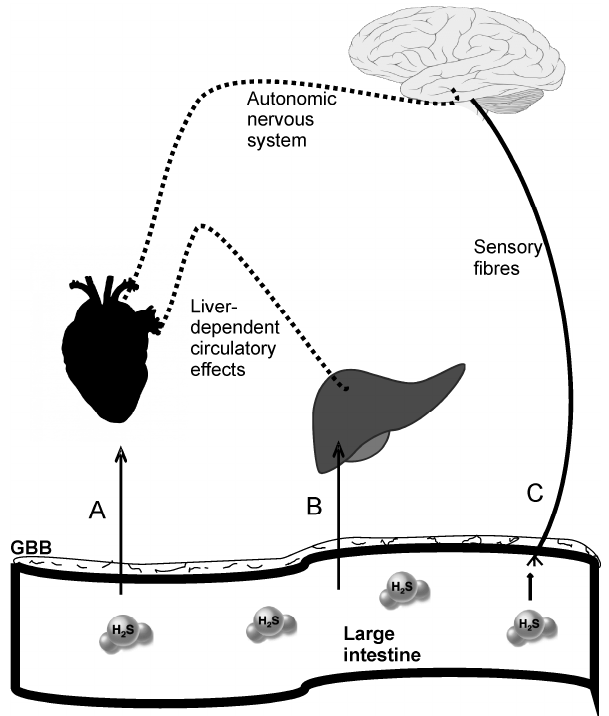
Figure 2. Postulated pathways of cardiovascular actions of gut-bacteria-derived hydrogen sulfide and its derivatives (H 2 S). ( A ) H 2 S crosses the gut-blood barrier (GBB), bypasses the liver ( rectal plexuses ) , and targets the heart and blood vessels; ( B ) H 2 S crosses the GBB and affects liver functions associated with the circulatory system homeostasis; ( C ) H 2 S stimulates sensory fibers of the enteric nervous system that project to the brain centers controlling the circulatory system via the autonomic nervous system.